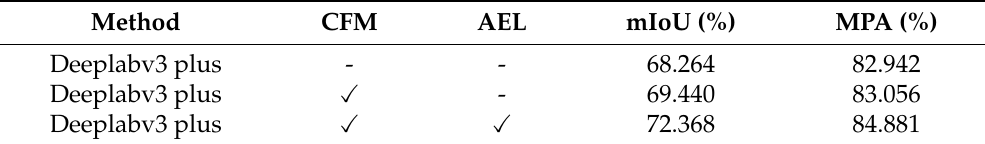
Table 4. Ablation study of Deeplab likewise models on Vaihingen dataset.